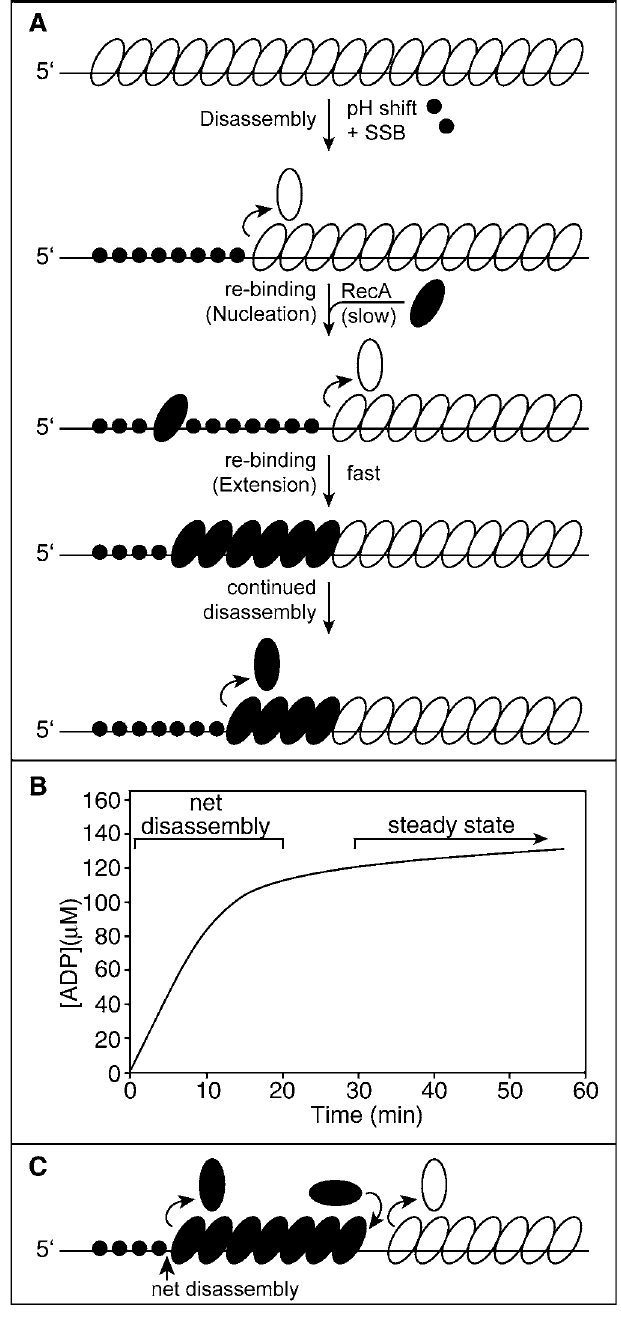
Figure 4. Model for RecA Filament Disassembly from Linear ssDNA (A) In the model, end-dependent disassembly occurs, with SSB filling in the vacated DNA. At low frequency, additional RecA monomers nucleate filament formation on the vacated DNA, and the new filament (dark ovals) extends until it catches up with the original filament (open ovals). This creates a new disassembling end. (B) Kinetics of disassembly as monitored by DNA-dependent ATP hydrolysis. This curve is an approximation of curves reported in previous work [27]. The rate of ATP hydrolysis declines as RecA protein dissociates from the ssDNA, until a lower steady-state rate is reached. The steady state reflects a balance between disassembly and new filament formation. (C) If, upon rebinding, the new filament does match the old one in phase, the junction between the old and new filaments could be a site of RecA monomer exchange with the solution. There will be no net disassembly at this point and no resulting change in the rate of